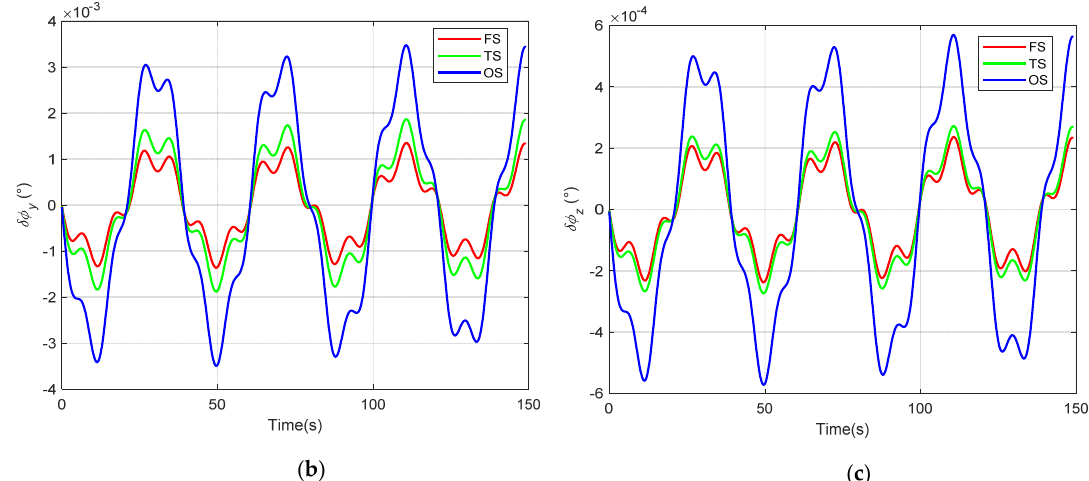
Table 2. The statistical properties of the simulation results for coning error.